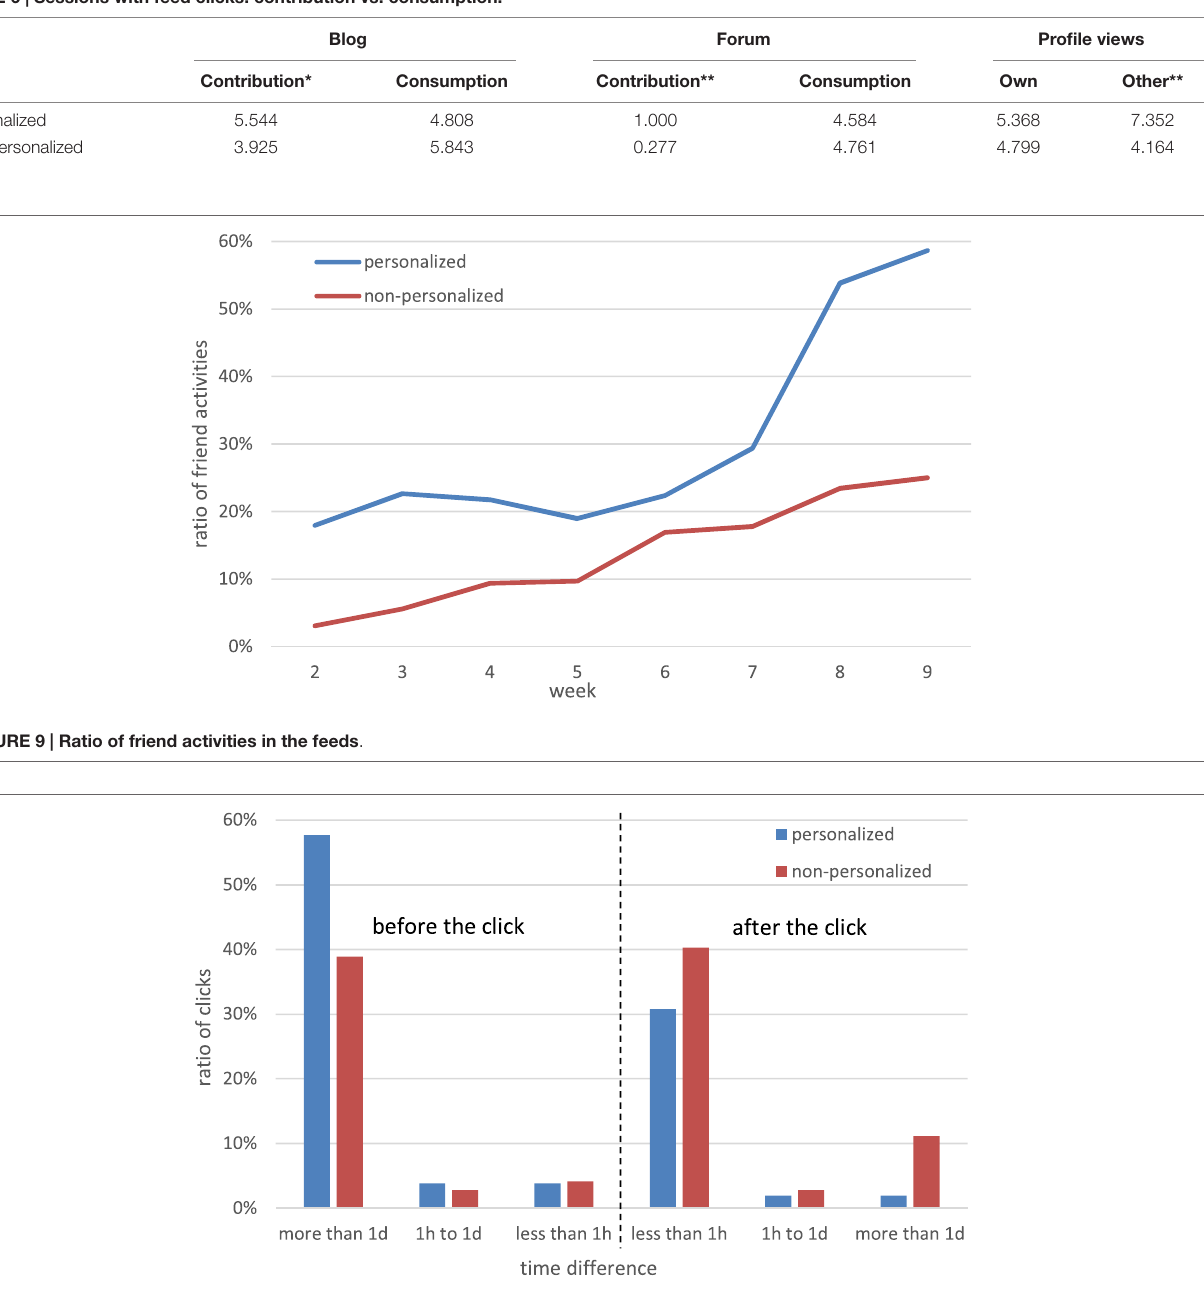
TaBle 6 | sessions with feed clicks: contribution vs. consumption.